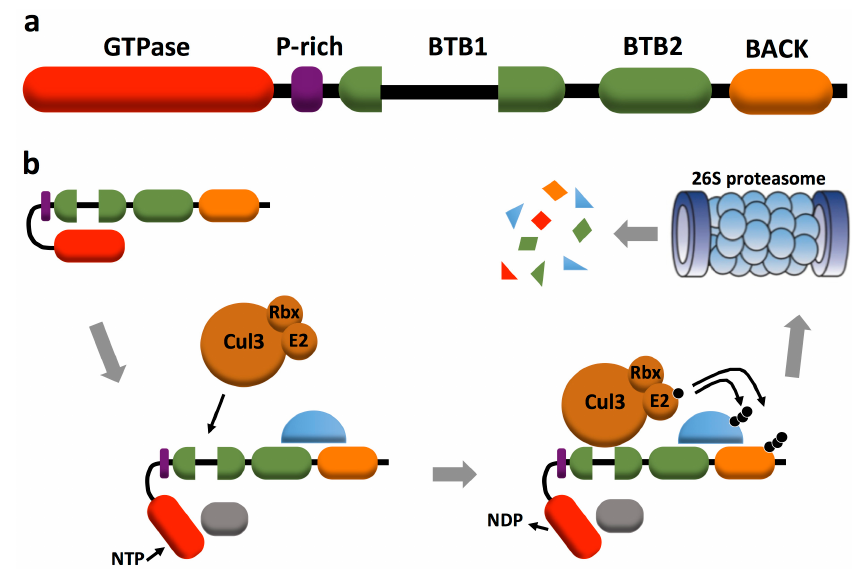
Figure 1. Architecture of RhoBTB proteins and proposed mechanism of regulation. ( a ) Domain structure of RhoBTB proteins. The GTPase domain is followed by a proline-rich region, a tandem of two BTB (broad complex, tramtrack, and bric-a-brac) domains (the first one is bipartite) and a carboxyl terminal BACK (BTB and C-terminal Kelch) domain. The cartoon is drawn roughly to scale and fits RhoBTB1 and RhoBTB2. RhoBTB3 has a shorter insert in the first BTB domain and it bears an isoprenylation (CAAX) motif at the end; and ( b ) a model depicting the hypothetical mechanism of activation and inactivation of RhoBTB. An intramolecular interaction of the GTPase domain with the first BTB domain maintains the molecule inactive. Interaction with specific ligands would provoke a conformational change that disrupts the intramolecular interaction. There is probably not a unique ligand binding site that causes activation of RhoBTB (two have been depicted in this model as examples). The GTPase domain would then be able to bind and hydrolyze GTP (in the case of RhoBTB2 and probably also RhoBTB1) or ATP (in the case of RhoBTB3) and the first BTB domain would be free to assemble a cullin 3-dependent ubiquitin ligase complex that would tag the ligands, as well as RhoBTB itself, for degradation in the proteasome. It has not been established whether nucleotide binding and cullin 3 binding are always linked.